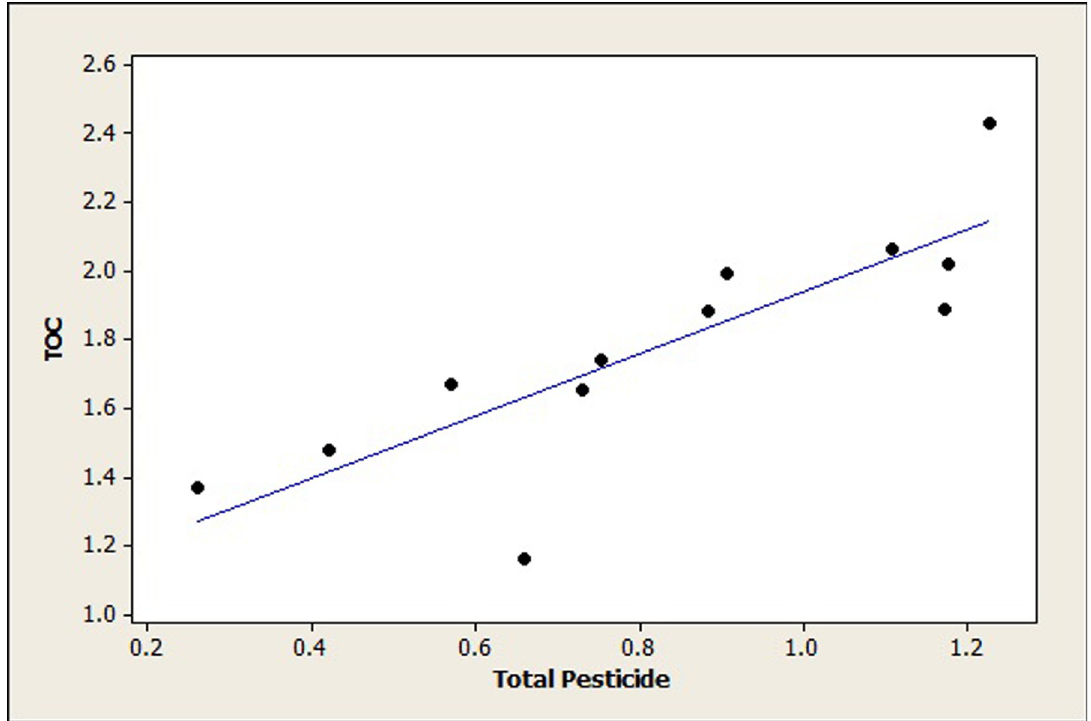
Fig 4. Correlation between total organic carbon and total pesticide concentration in sediment samples collected from three stations of river Ganga (r 2 = 0.8).